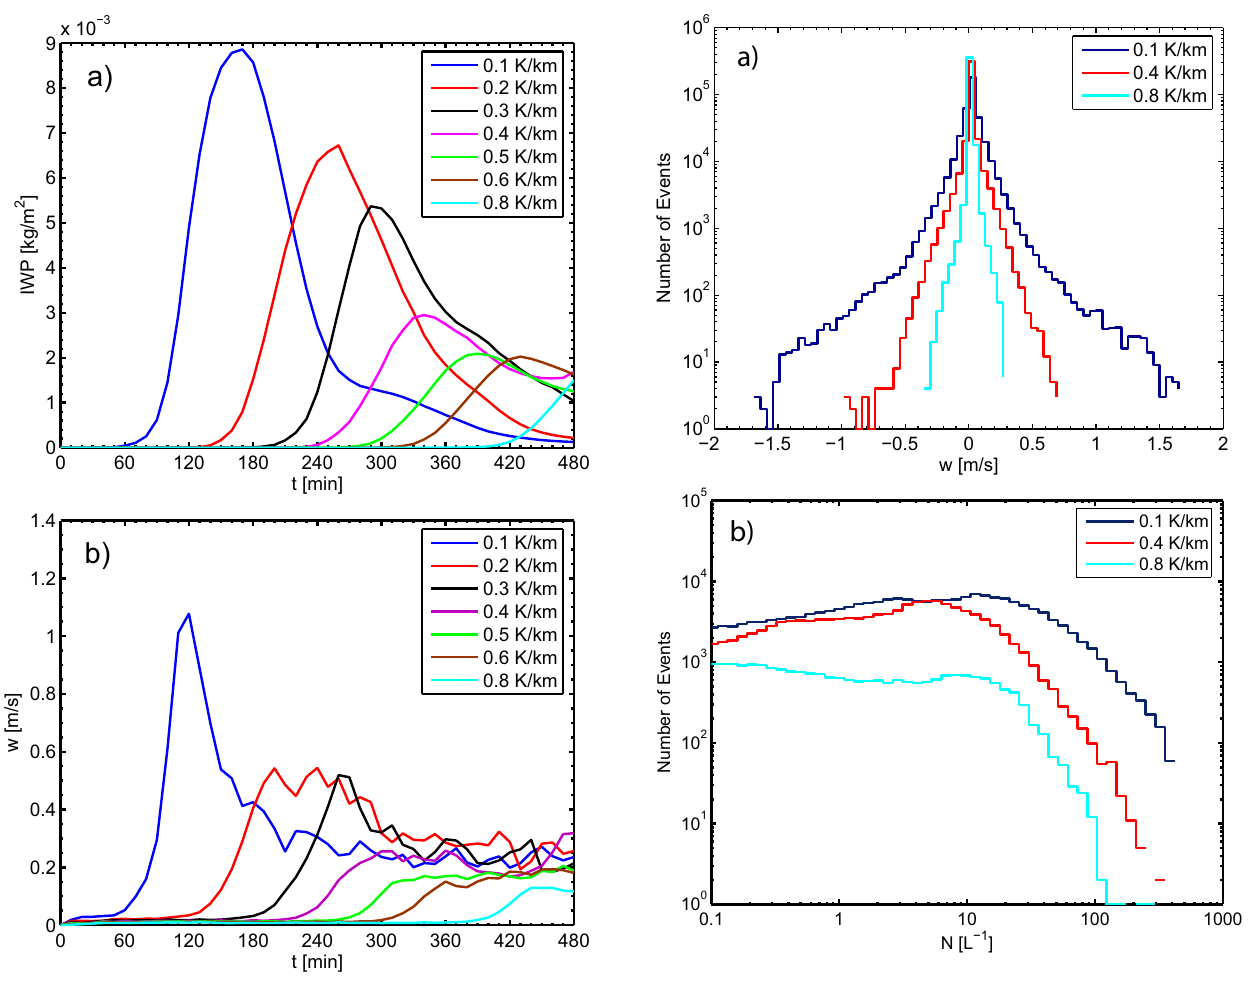
Fig. 6. (a) IWP (averaged over all columns) for thermal stratifica- tion ∂θ/∂z = 0 . 1 to 0 . 8 K / km. The purple line represents the ref- erence case; (b) median of the maximum 5% vertical wind speeds within the ISSR for thermal stratification ∂θ/∂z = 0 . 1 to 0 . 8K / km. The purple line represents the reference case.